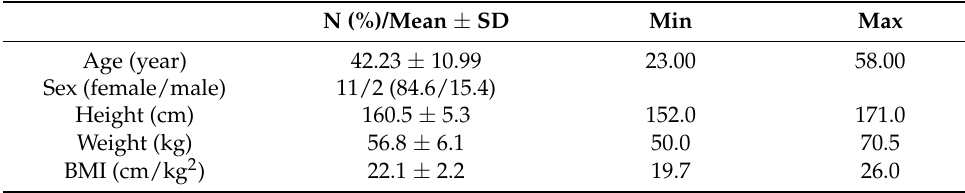
Table 2. General characteristics of the participants (N =